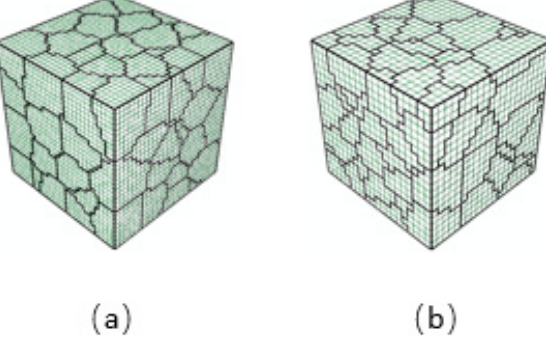
Figure 11. RVE models with different mesh size: ( a ) contains 30 × 30 × 30 (27,000) elements; ( b ) contains 20 × 20 × 20 (8,000) elements.